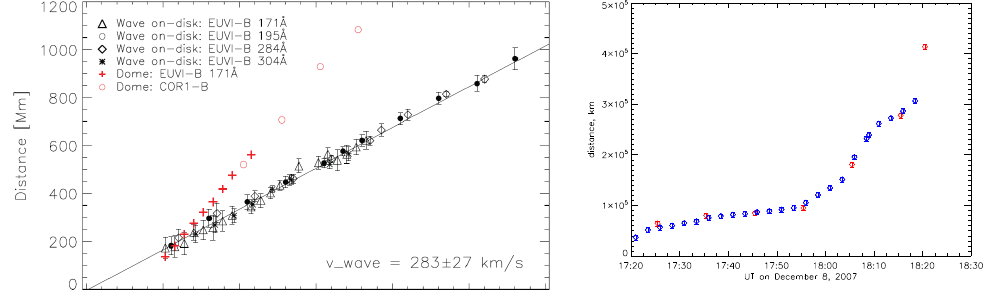
Figure 24: Left : distance-time plot of the coronal wave of 2010 Jan 17, derived from STEREO/EUVI data. The on-disk wave has a constant speed of 283 km s –1 , while the wave dome expands faster in the radial direction (adapted from Veronig et al. , 2010). Right : distance-time plot of the coronal wave of 2008 Dec 8, derived from STEREO/EUVI data. The wave shows an erratic propagation: a slow initial speed, and phases of abrupt acceleration and deceleration. Images reproduced with permission from [left] Veronig et al. (2010), copyright by AAS; and from [right] Zhukov et al. (2009), copyright by